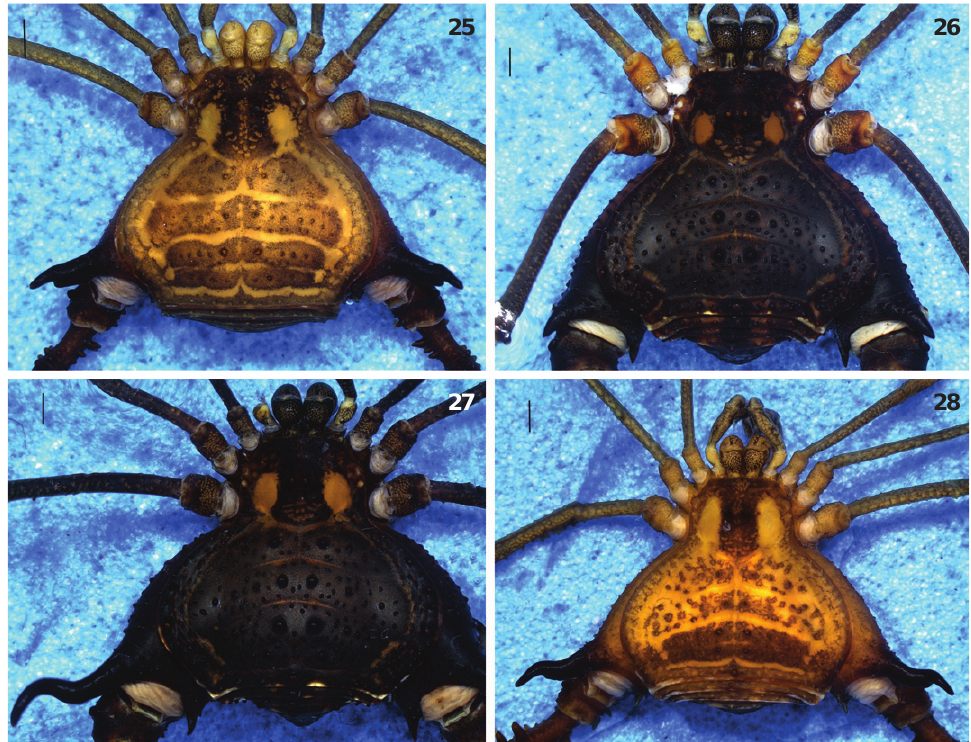
Figures 25-28. Males of Parampheres in dorsal view: (25) P. bimaculatus , MCNRS0726; (26) P. lucidus , MCNRS1615; (27) P. tenebris sp. nov. , MCNRS0044; (28) P. pectinatus , MCNRS1364. Scale bars: 1